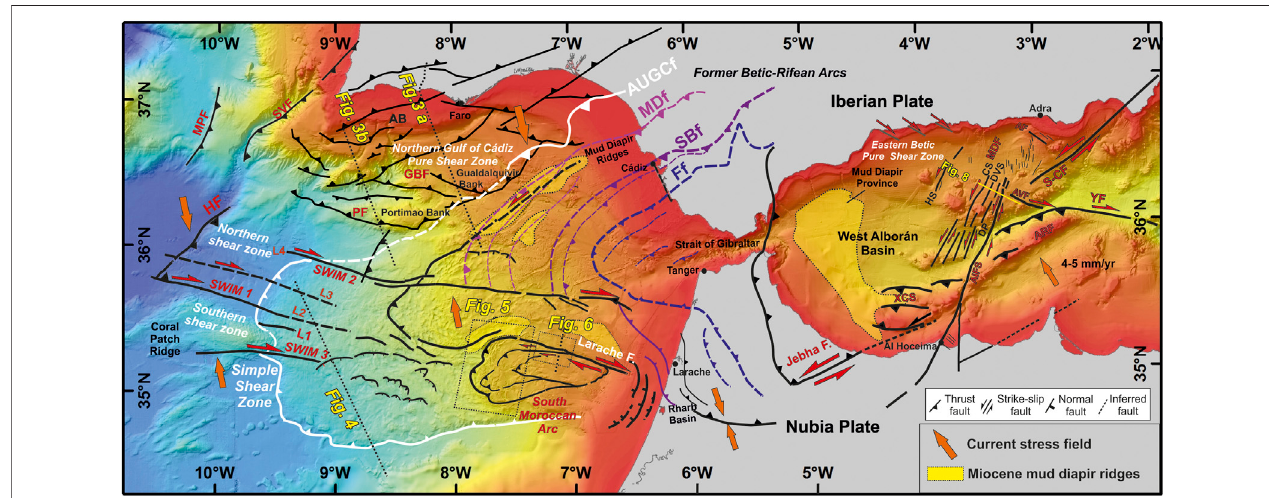
FIGURE 2 | Synthetic map of active submarine faults in the Gulf of Cadiz and the Alborán Sea along the Iberia-Africa plate boundary and location of fi gures. The plate boundary is partitioned into the main stress areas: (i) the SW Iberian Margin simple shear zone; (ii) the Gulf of Cadiz pure shear zone; (iii) the South Moroccan compressionalarc;and(iv)theEasternBeticpureshearzone.Abbreviationsofthesubmarineactivefaultsarelistedin Table1 .CS:CalahondaSoundFault;DP:Djibouti Passage Fault; DVS: Djibouti Ville Fault: HS: Herradura Sound Fault; XCS: Xauen Compressive System; AB: Algarve Basin; Units of the Betic-Ri fi an arc (modi fi ed fromMedialdeaetal.,2009a)arealsoshown:Ff:FlyschUnitsfront;SBf:Subbeticfront;MDf:Muddiapiricfront,AUGCf:BoundaryoftheAllochthonousUnitoftheGulfof Cádiz;IB:Ibn-Batouta Bank LHB:LaHerraduraBankBathymetryfromSWIMcompilation(Zitellinietal.,2009)andEMODnetproject(http://www.emodnet.eu).Present- day stress fi elds from Pedrera et al.